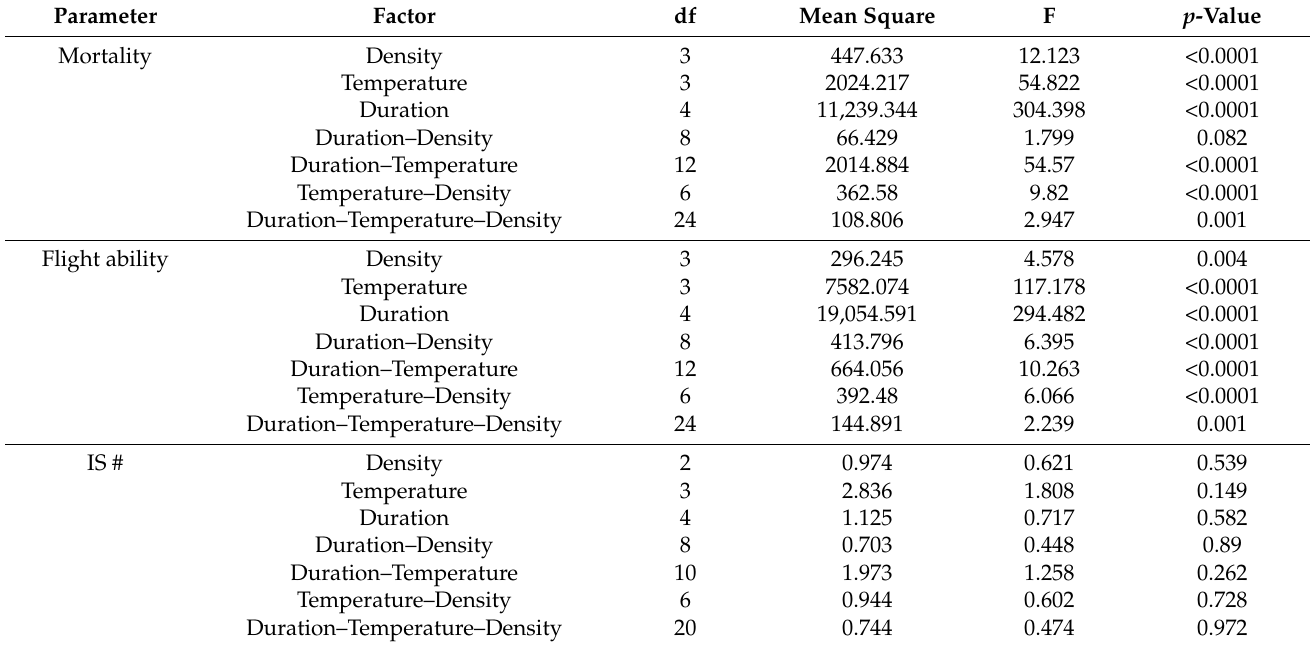
Table 1. The GLM analysis results regarding the effects of density, temperature, and duration factors on mortality, flight ability, and induced sterility of gamma-sterilized male Ae. aegypti .